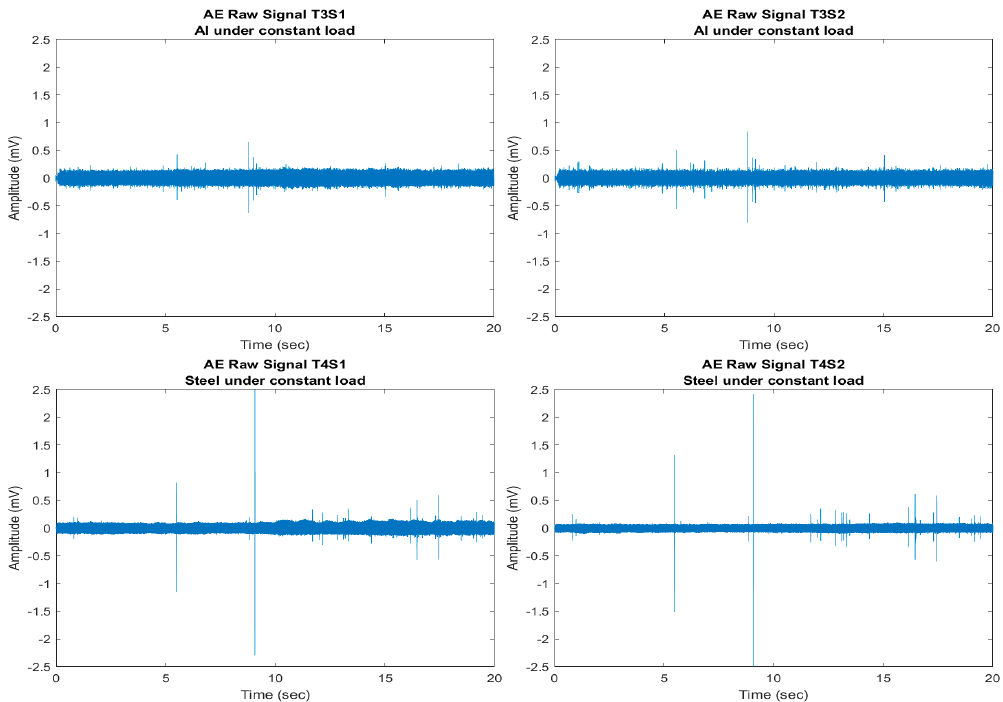
Figure 12. Raw AE data from the constant load tests.